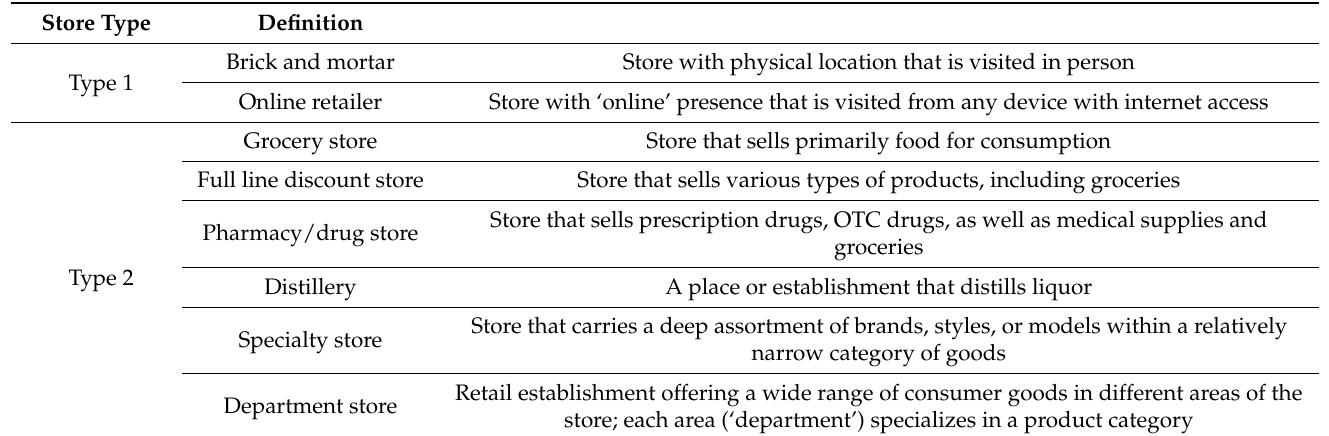
Table 1. Store Type Categories and Definitions.